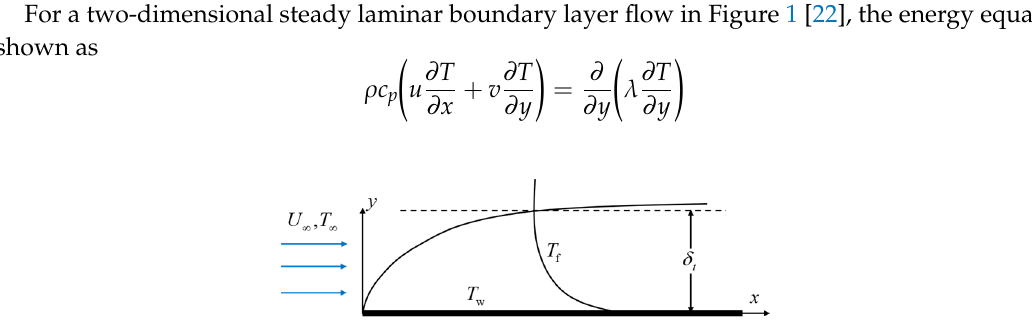
Figure 1. The schematic of boundary flow over a plate.